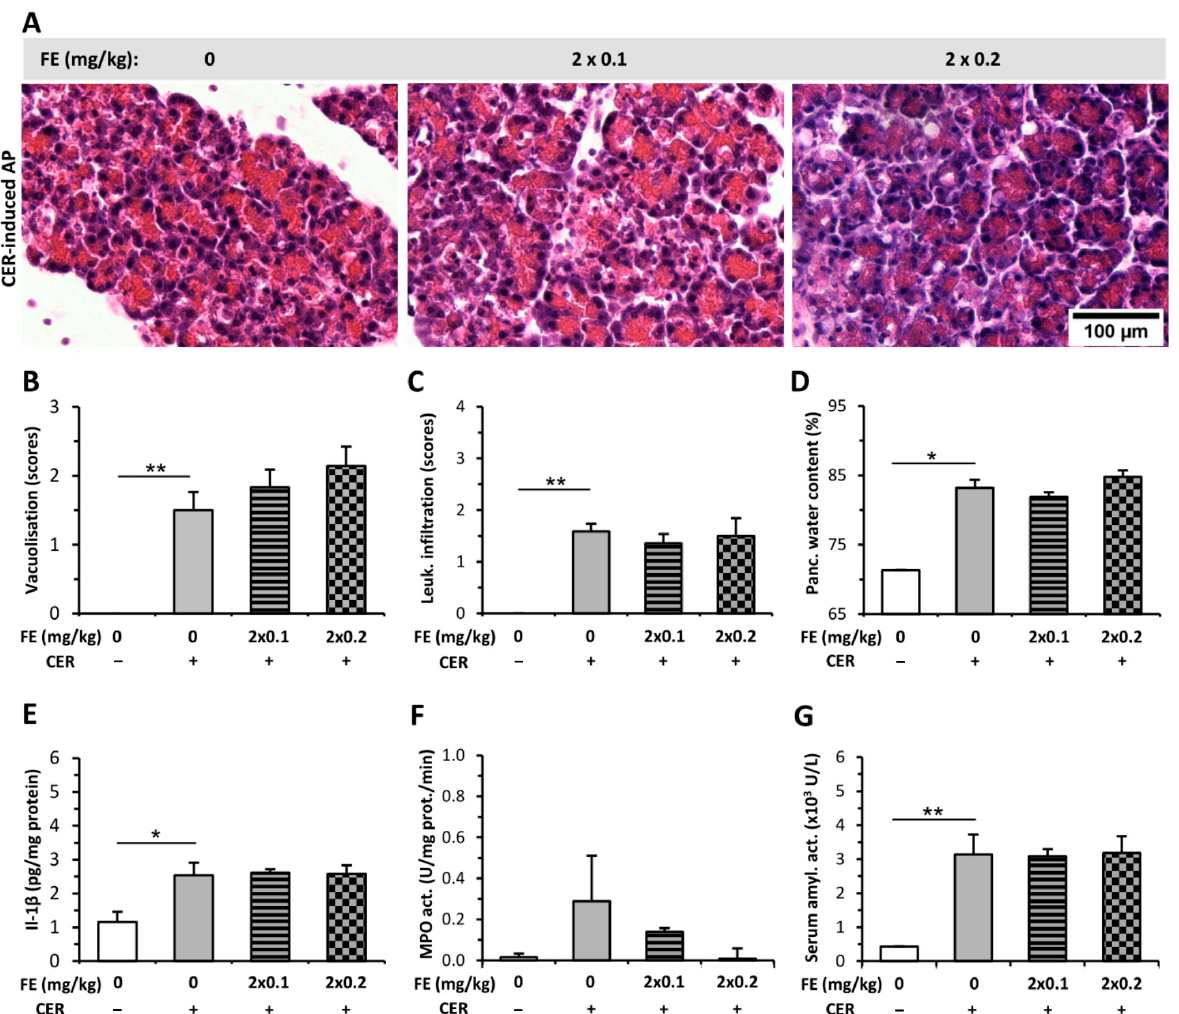
Figure 2. Fentanyl (FE) treatment started before the induction of mild acute pancreatitis (AP) with cerulein (CER) does not affect disease severity. Rats were treated with 2 × 0.1 or 2 × 0.2 mg/kg FE i.p., whereas i.p. injection with 4 × 20 µg/kg CER (CER +) was used to induce AP. Control animals images of pancreatic tissues of the treatment groups. Bar charts show the extent of pancreatic ( B